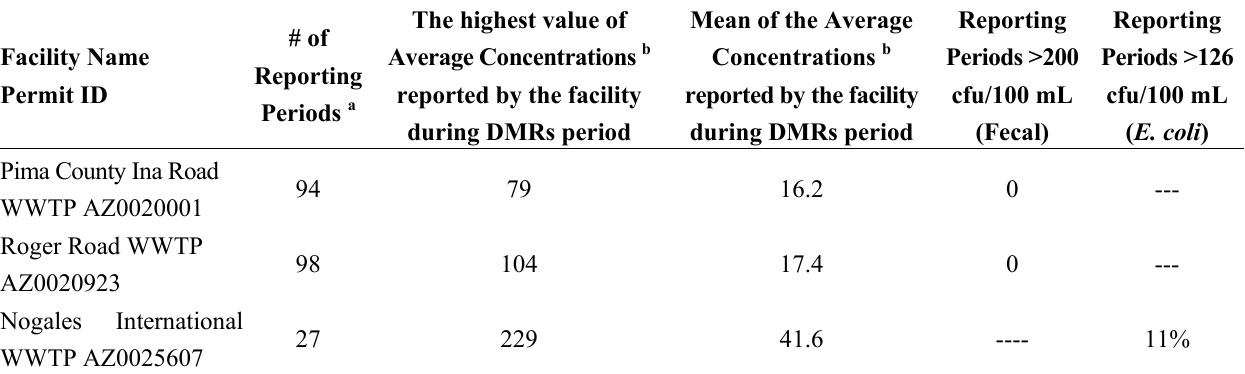
Table 3. Summary of the averaged concentrations reported during each DMRs period compared to the fecal coliform geometric mean standard of 200 cfu/100 mL or the E. coli geometric mean standard of 126 cfu/100 mL for FBC and